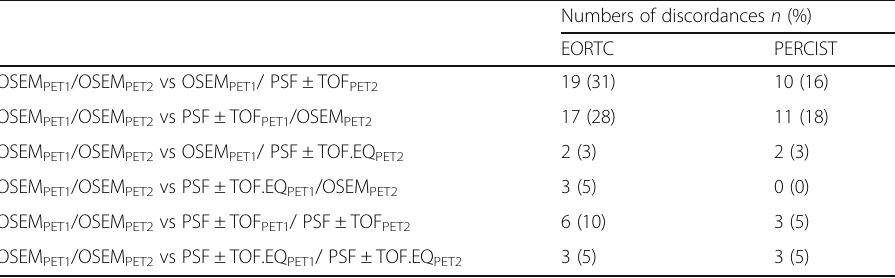
Table 3 Number of discordances between the OSEM 1 /OSEM 2 scenario and other scenarios involving reconstruction inconsistency for EORTC and PERCIST therapeutic